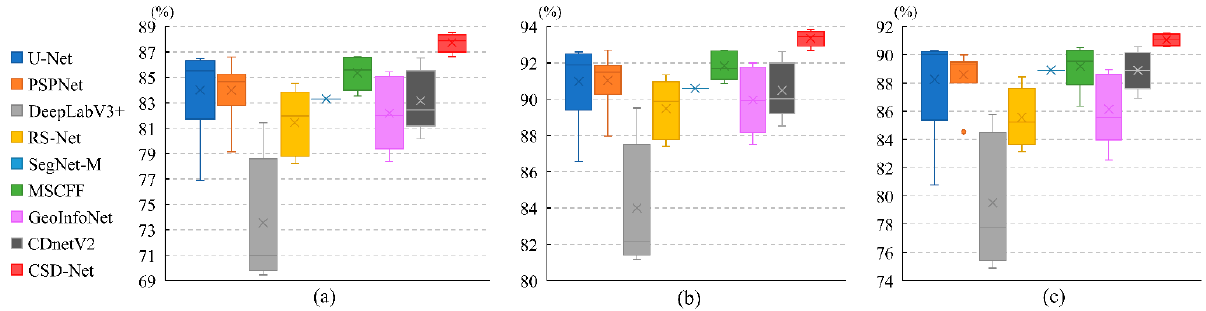
Figure 15. The box graphs of accuracy metrics for various deep learning methods. ( a – c ) The numerical distribution of MIoU, Macro-F1, and Kappa. The cross in the box represents the median of all values, while the horizontal line denotes the mean value.